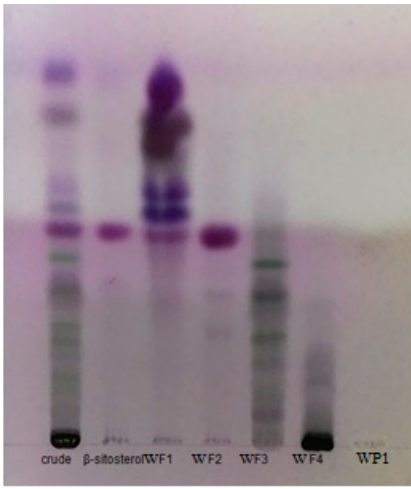
Figure 1. Thin layer chromatography (TLC) chromatogram of W. globosa extract developed in an acetone:hexane ratio of 20:60, sprayed with a vanillin-sulfuric agent.